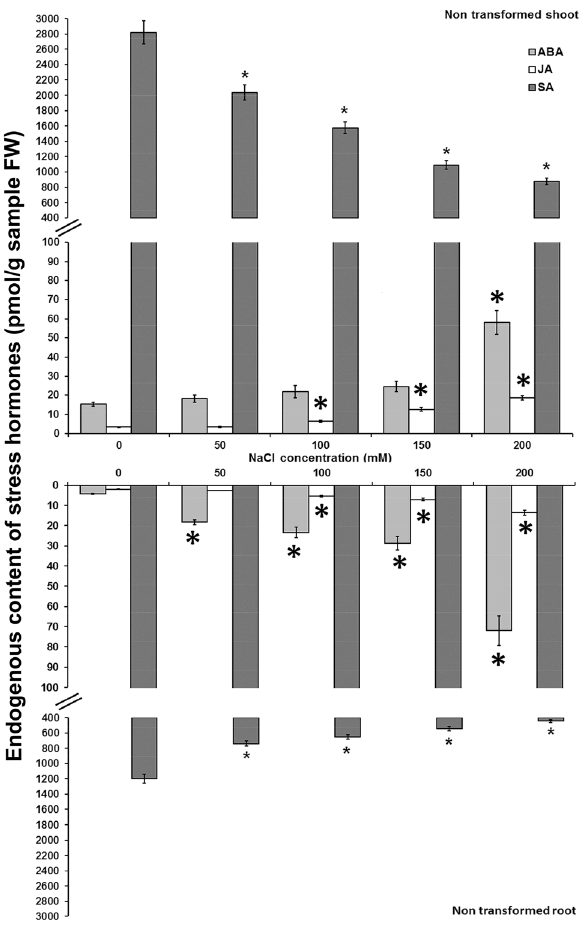
Figure 6. Endogenous ABA, JA and SA contents and in shoots and roots of 8-week-old non-transformed Centaurium erythraea line. Data represent mean ± standard error. Means marked with asterisks are significantly different from corresponding control values (LSD test, p ≤ 0.05). The bigger asterisks represent the values significantly higher than control ones while smaller asterisks represent values significantly lower than control